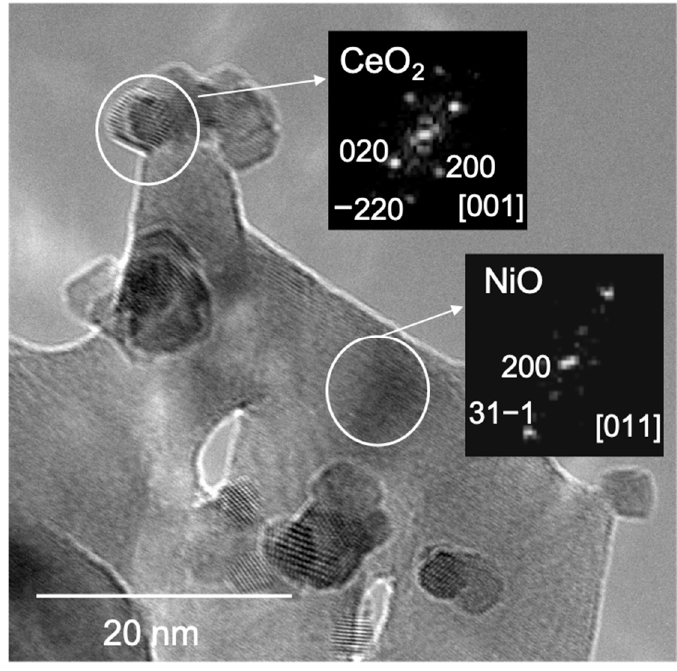
Figure 3. TEM image corresponding to the as-prepared NiOCeO 2 -8 catalyst.